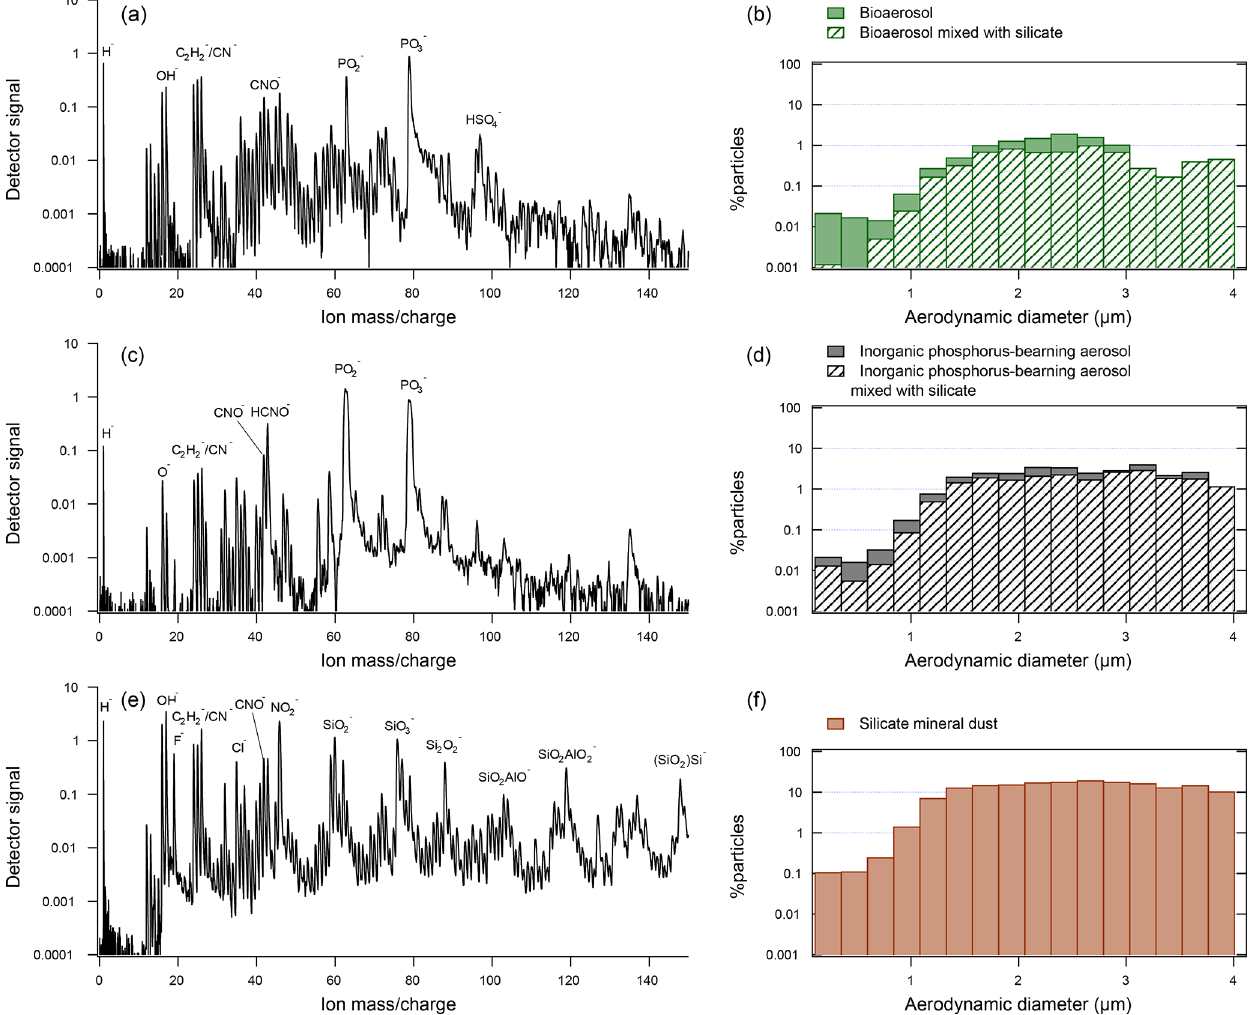
Figure 2. Representative spectra and size distributions of the three types of particles considered in this study: (a) representative spec- trum of bioaerosol (DC3 campaign). (b) Size distribution of bioaerosol particles in DC3, SEAC 4 RS, NEAQS, MACPEX, and FIN03. The hatched pattern indicates the percentage of particles that also exhibited silicate mineral markers. (c) Representative spectrum of an inorganic phosphorous-rich particle (DC3 campaign). (d) Size distributions of inorganic phosphorous-rich particles in DC3, SEAC 4 RS, NEAQS, MACPEX, and FIN03 campaigns. (e) Representative spectrum of a silicate mineral dust particle (DC3 campaign). (f) Size distributions of mineral dust particles in DC3, SEAC 4 RS, NEAQS, MACPEX, and FIN03